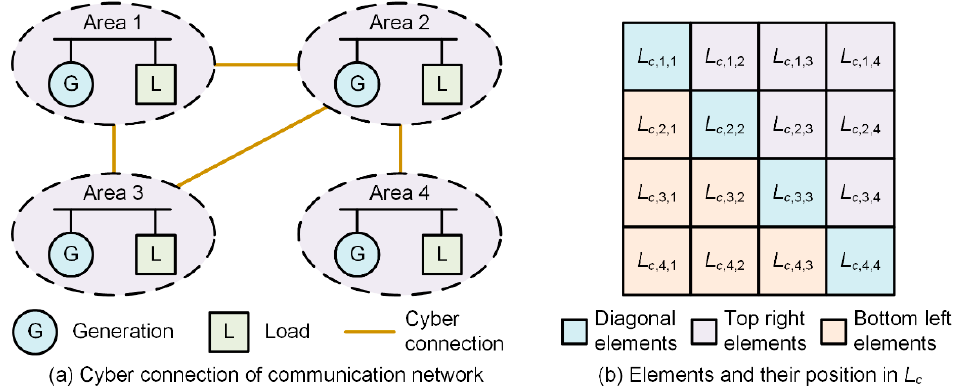
Figure 2. Communication network and the corresponding Laplacian matrix.